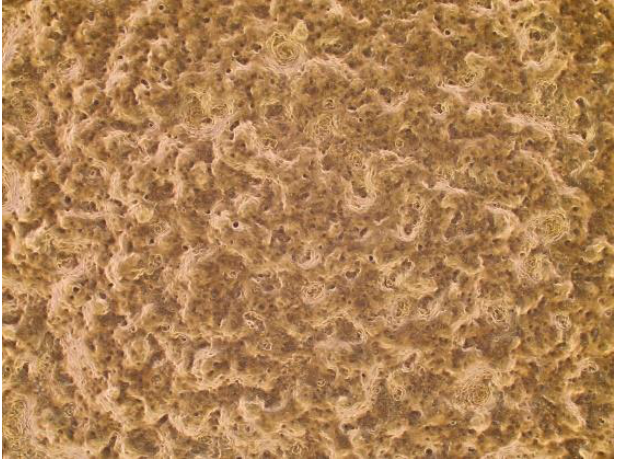
Figure 7. Histology of normal EC mucosal layer successfully grown on air-interfaced plate. The magnification scale is 4 ×